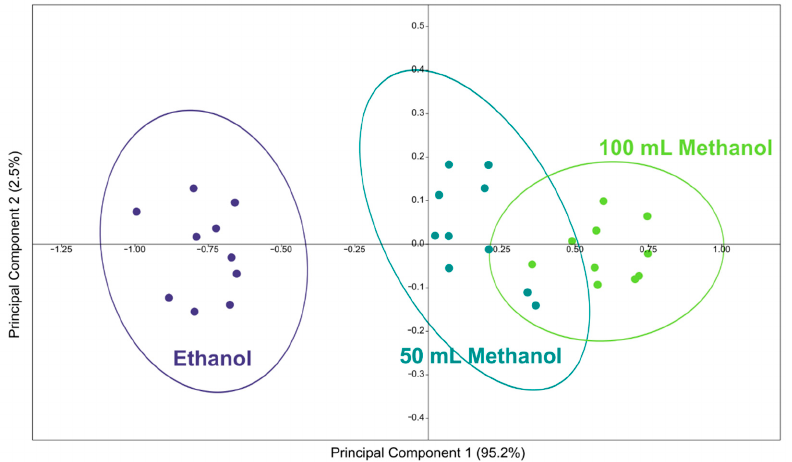
Figure 6. Principal components plot for alcoholic mixtures at 40° of pure ethanol in distilled water, with 50 mL of methanol, and 100 mL of methanol.